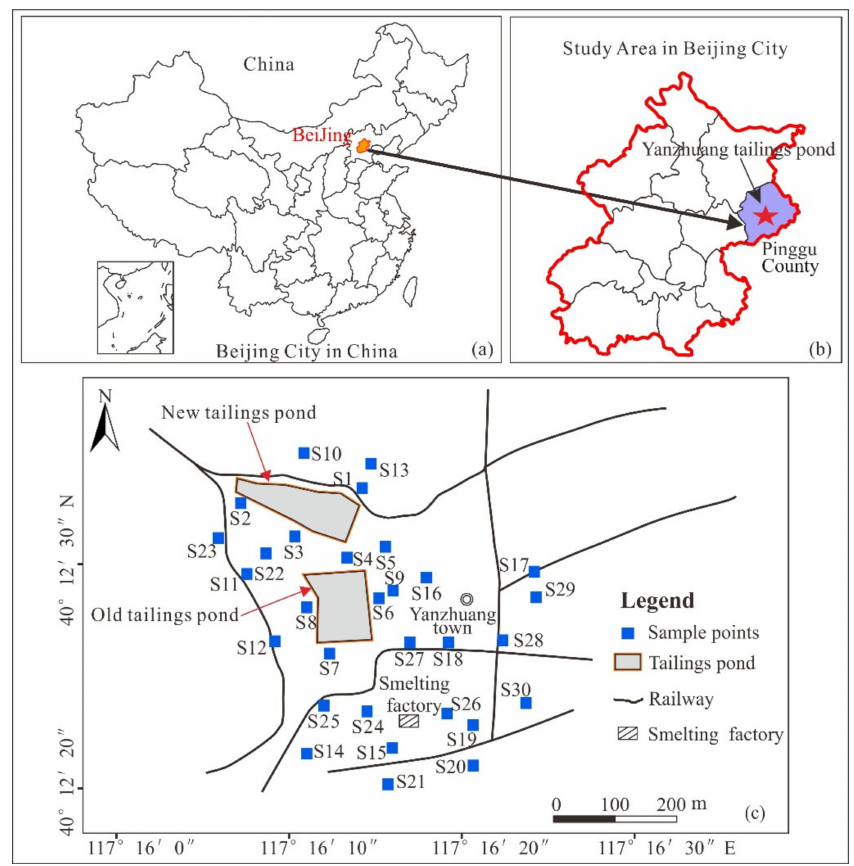
Figure 1. ( a ) Geographic location of China. ( b ) The location of the study area in Beijing. ( c ) Schematic map of the studied area and sampling